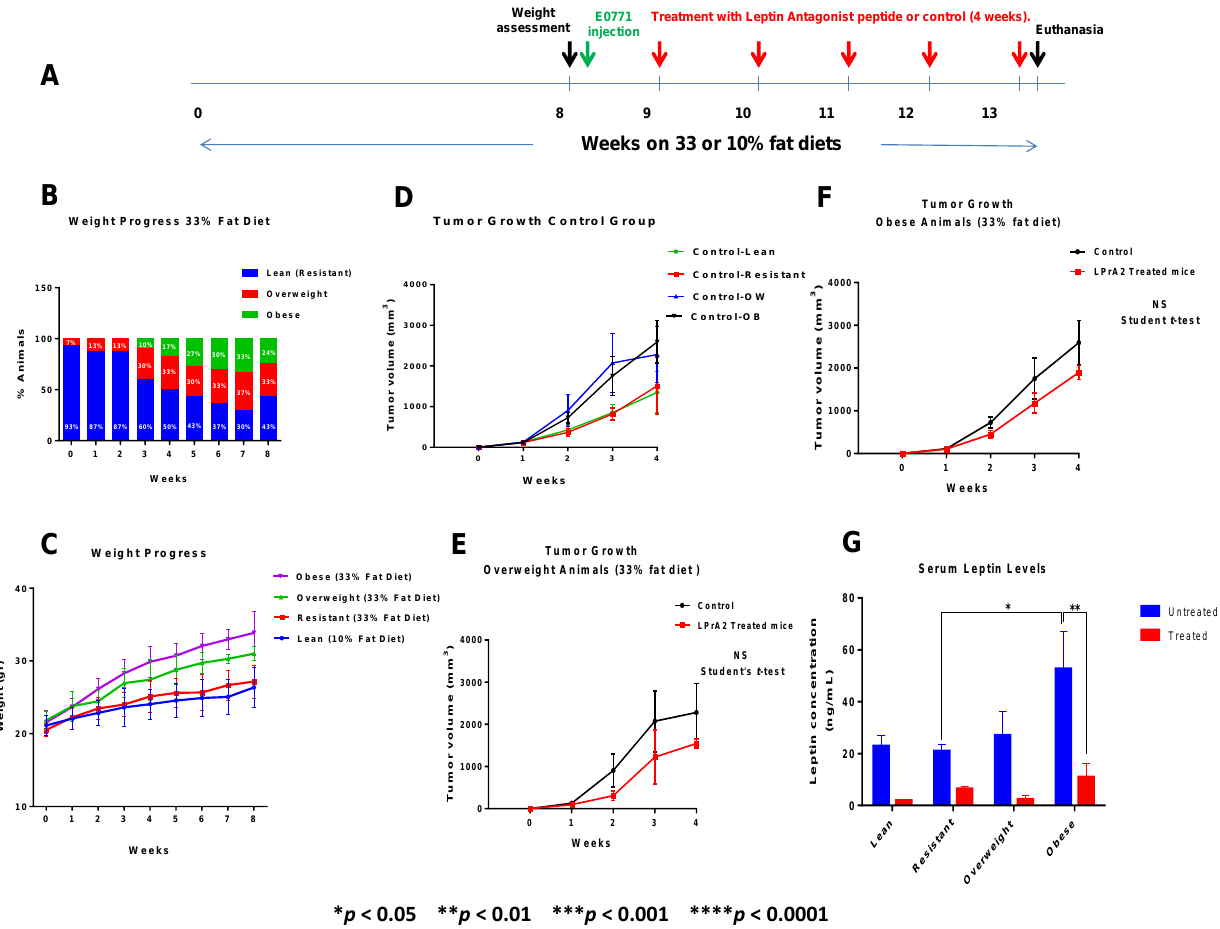
Figure 9. In vivo experiments: weight control and tumor progression. ( A ) Experimental design of the in vivo experiments. ( B ) Feeding 33%Kcal/fat HFD results in a rapid